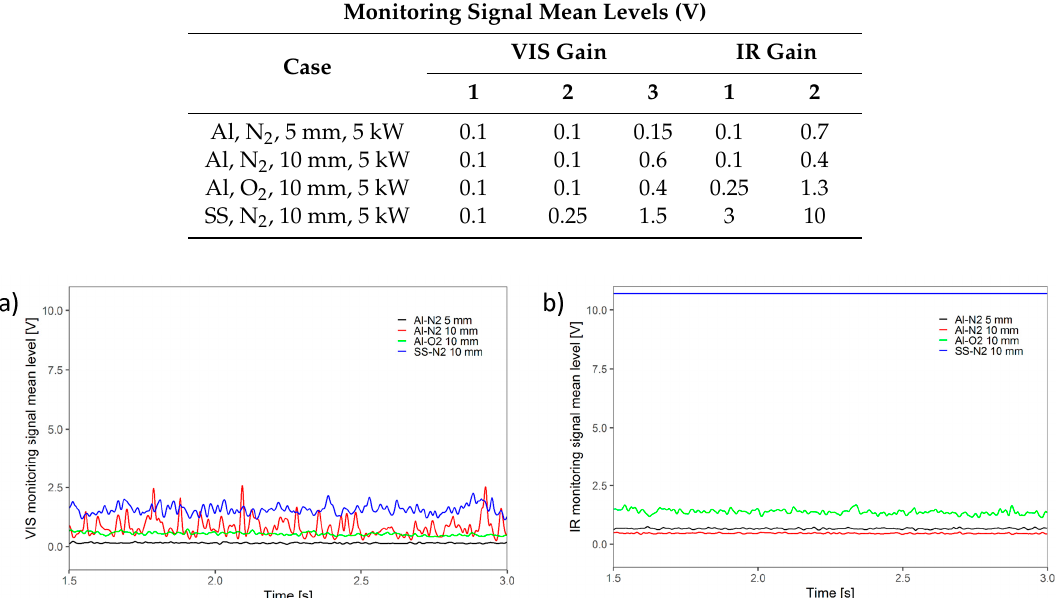
Figure 2. Monitoring signal mean levels for ideal laser cutting process parameters: ( a ) Visible spectrum and gain 3; ( b ) Infrared spectrum and gain 2.